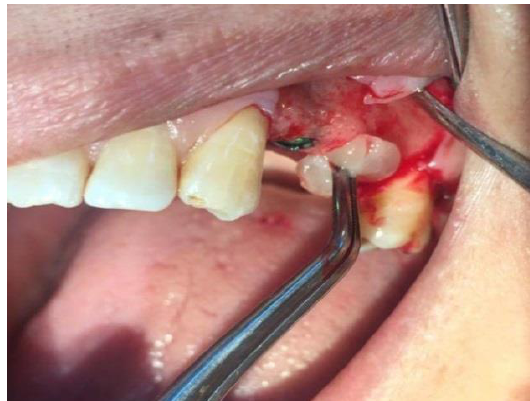
Figure (3): Application of PRF clots at site No.13.